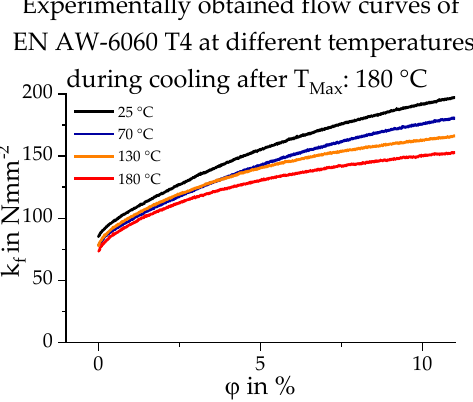
Figure 15. Experimentally obtained flow curves of alloy EN AW-6060 T4 at different temperatures during cooling after a 180 °C maximum temperature (phase A).